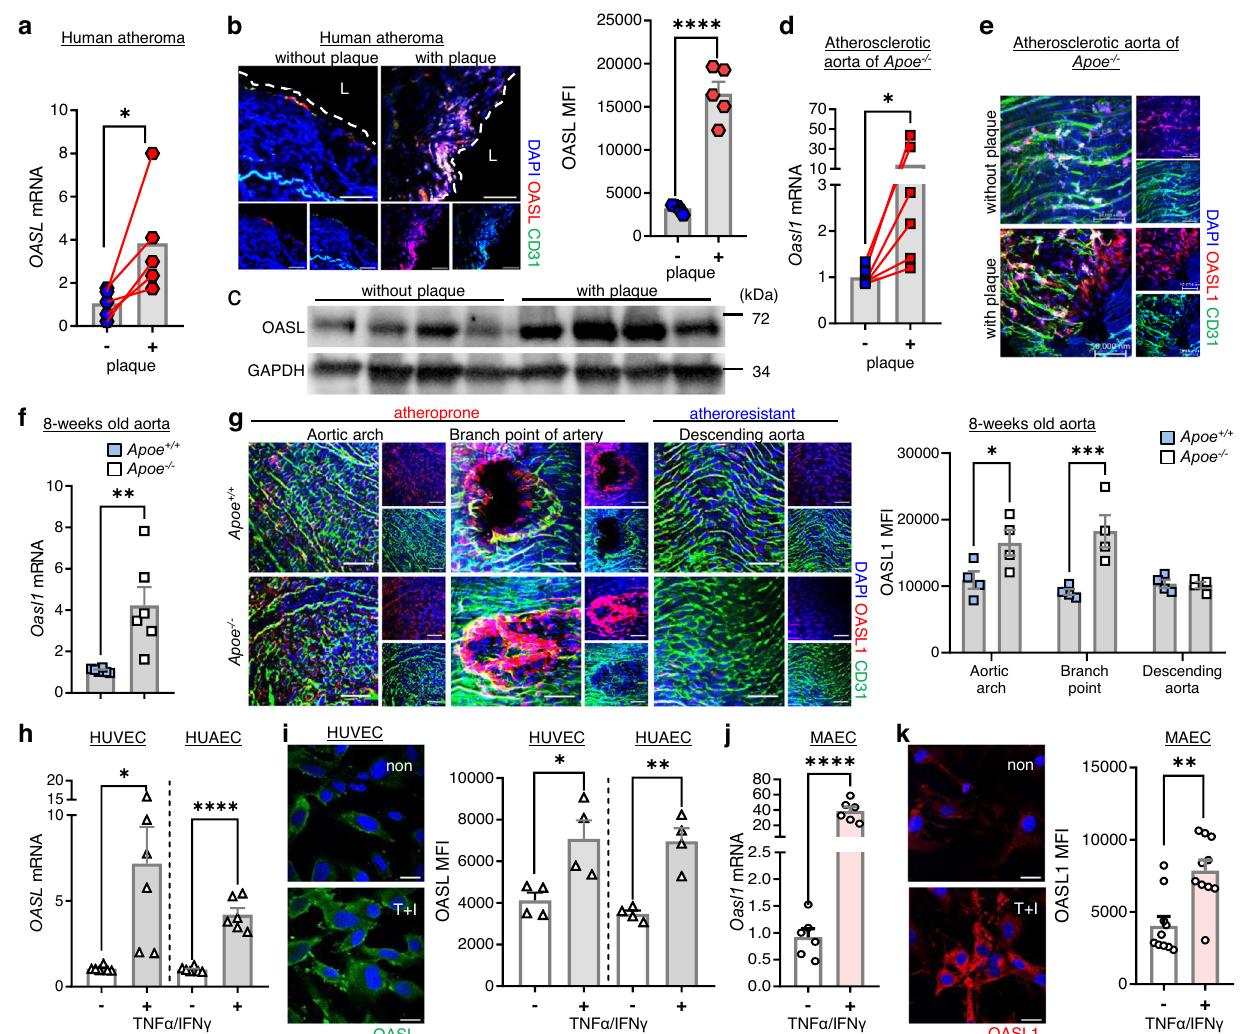
Fig. 1 | Expression of human OASL and murine OASL1 are increased in athero- proneaorticECs.a – c Human atheromatissueswithorwithoutplaqueswereused to measure OASL expression. a OASL mRNA levels ( p =0.0463, n=5) were mea- sured by quantitative PCR. b Left: Immuno fl uorescence (IF) staining of OASL pro- tein and CD31 + ECs ( p <0.0001, n =5 per group). Right: Quantitation of mean fl uorescenceintensity(MFI).Scalebar,50 μ m.L,lumen.( c )Westernblotanalysisof OASL expression ( n =4 per group). d , e Atherosclerotic aortas were isolated from Apoe − / − mice fed a normal chow diet (NCD) for 28 weeks. Oasl1 mRNA levels ( p =0.0313, n =6) ( d ) and en face IF staining for OASL1 and CD31 + aortic ECs ( n =5 per group) ( e ) in matched aortic specimens with and without plaques are shown. Scale bar, 50 μ m. f , g Aorta tissues were isolated from Apoe +/+ and Apoe − / − mice fed an NCD for 8 weeks. f mRNA levels of Oasl1 in aortas of each group ( p =0.0055, n =6 per group) as measured by quantitative PCR. g Left: En face IF staining for OASL1 and CD31 + ECs in athero-prone or athero-resistant regions. Right: